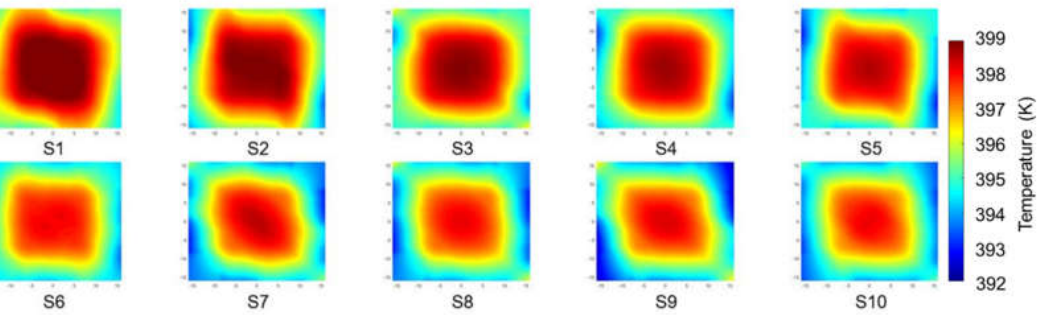
Figure 10. Temperature contours of different cross-sections of the “PS”.